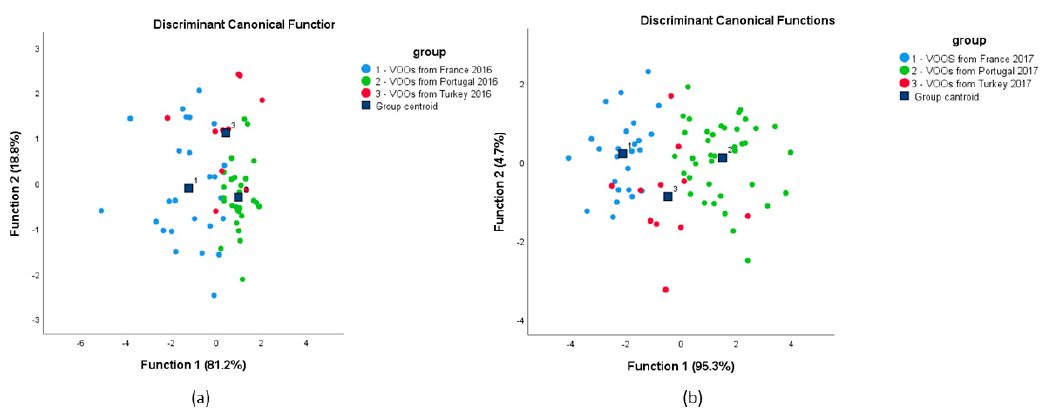
Figure 5. Linear discriminant analysis performed on isotope composition of EVOO samples ( δ 13 C, δ 18 O and δ 2 H) from 2016 ( a ) and 2017 ( b ).